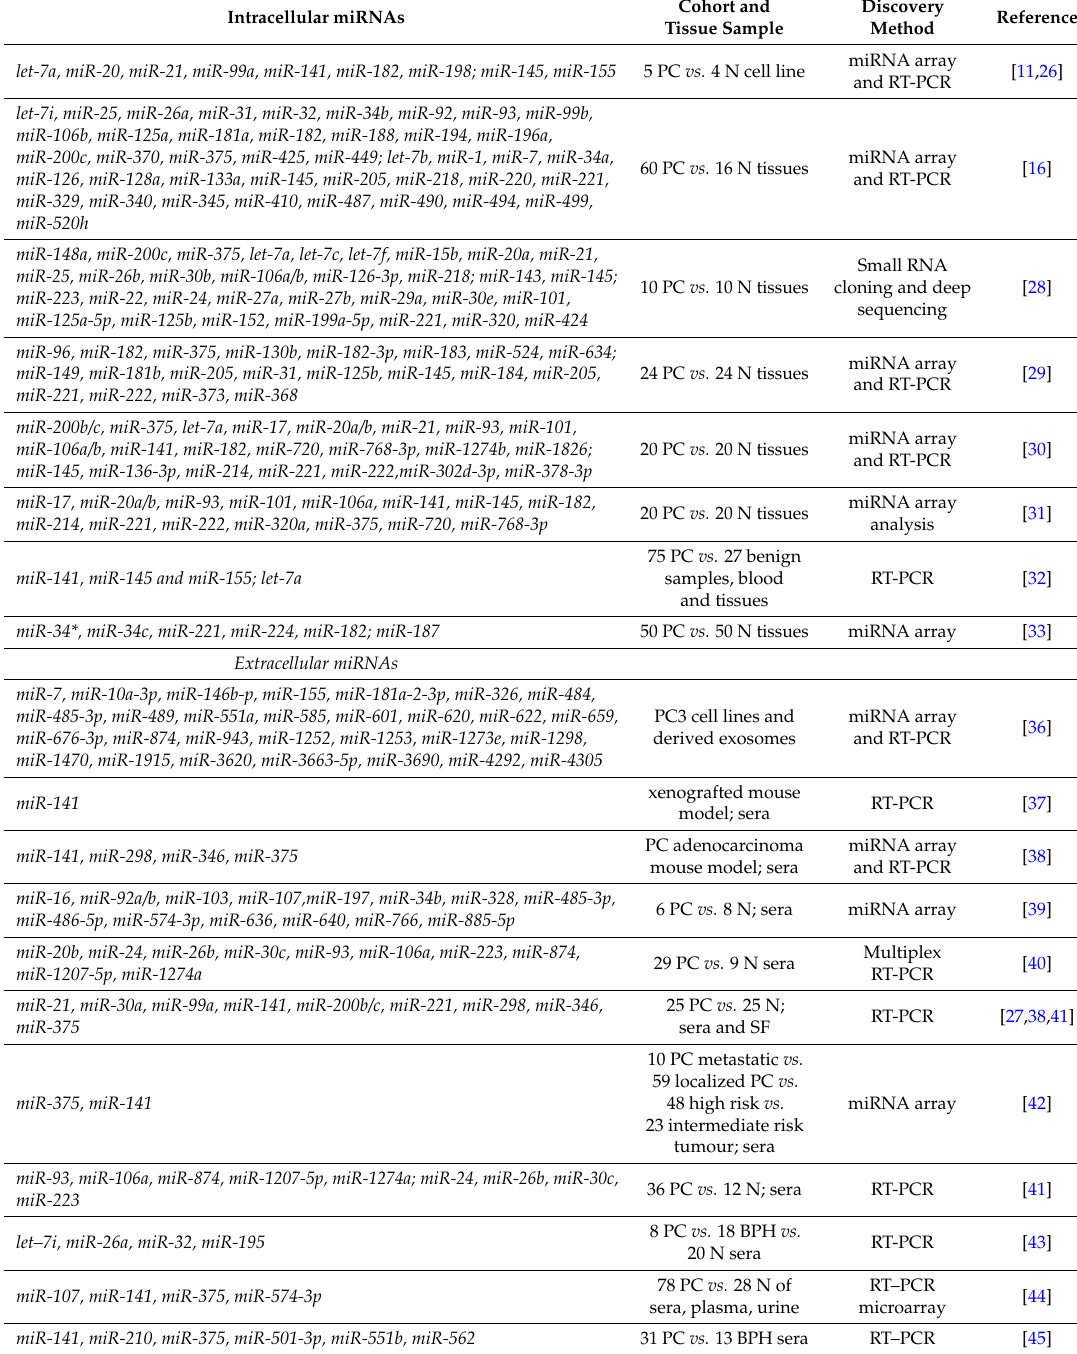
Table 1. miRNAs with a role in the diagnosis of PC. Extracellular and intracellular miRNAs are indicated. PC = prostate cancer, N = normal, BPH = benign prostatic hyperplasia, SF = seminal fluid, RT-PCR = real